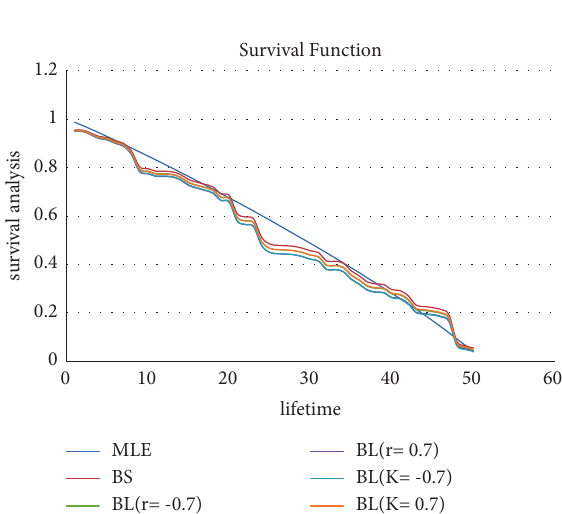
Figure 1: Estimate of the survival function from the R